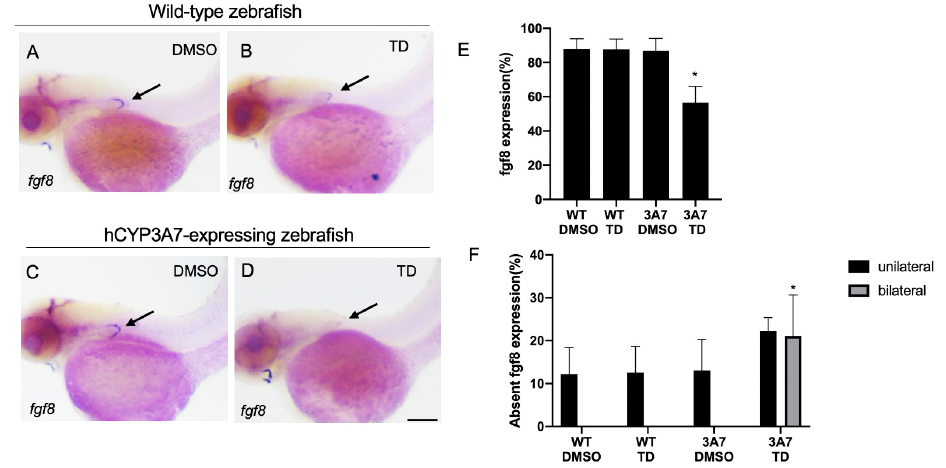
Figure 5. Thalidomide-induced reduction in fgf8 expression in pectoral fin buds of hCYP3A7-expressing zebrafish. Wild-type (WT) ( A , B ) and hCYP3A7-expressing embryos/larvae (CYP3A7) ( C , D ) were exposed to 200 µM thalidomide (TD) or 0.02% DMSO (DMSO) as a vehicle from 17 hpf until 48 hpf. Larvae were fixed at 48 hpf for whole-mount in situ hybridization with an fgf8 probe. Summarized data are presented as graphs in ( E , F ) ( n = 3, 7–10 embryos for each case). ( E , F ) indicate percentages of fgf8 expression and percentages of unilateral and bilateral loss of fgf8 expression in the presence or absence of thalidomide. * p < 0.05. Scale bar =100 µm.